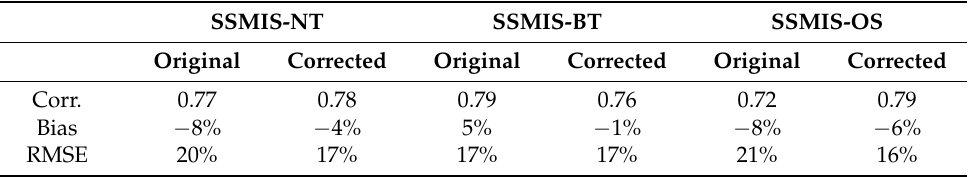
Table 3. The correlation coefficients (Corr.), mean biases, and RMSEs of original and corrected 2D distributions of the SSMIS-based SICs for 6 September 2019, compared with the 2D distribution of the MODIS-AMSR2 SIC on that